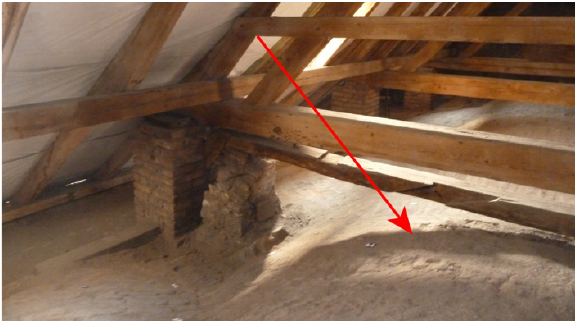
Figure 8. The arch built at the end of the first construction phase